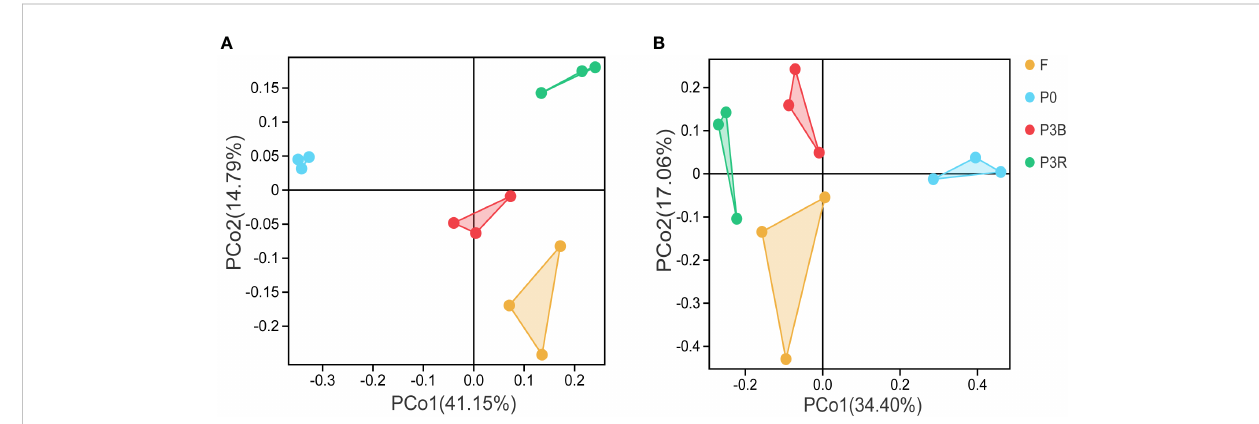
FIGURE 3 PCoA of microbial communities at the phylum level. (A) Bacteria; (B) Fungi. P0, control soil; F, one-year fallow soil; P3R, Rhizosphere soil after three years consecutive monoculture; P3B, Bulk soil after three years consecutive